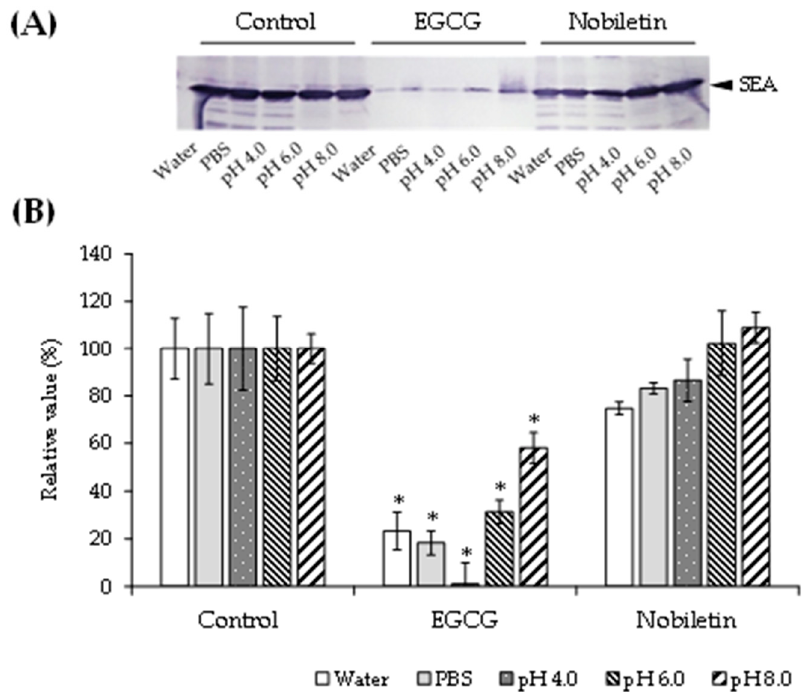
Figure 3. The effect of pH on the interaction between SEA and polyphenols. All samples were prepared at a final concentration of 3.0 mM. Each test sample was mixed with SEA (5.0 µ g/mL) in 100 μ L of Milli-Q water, PBS (pH 7.2), or McIlvaine buffer (pH 4.0, 6.0, or 8.0) and incubated at 37 °C for 24 h. Following centrifugation (4000× g , 5 min), the supernatant was applied to SDS-PAGE and visualized by Western blotting. Milli-Q water was used as a positive control. * p < 0.05 vs. the control. The values represent the mean ± standard deviation of three independent experiments.